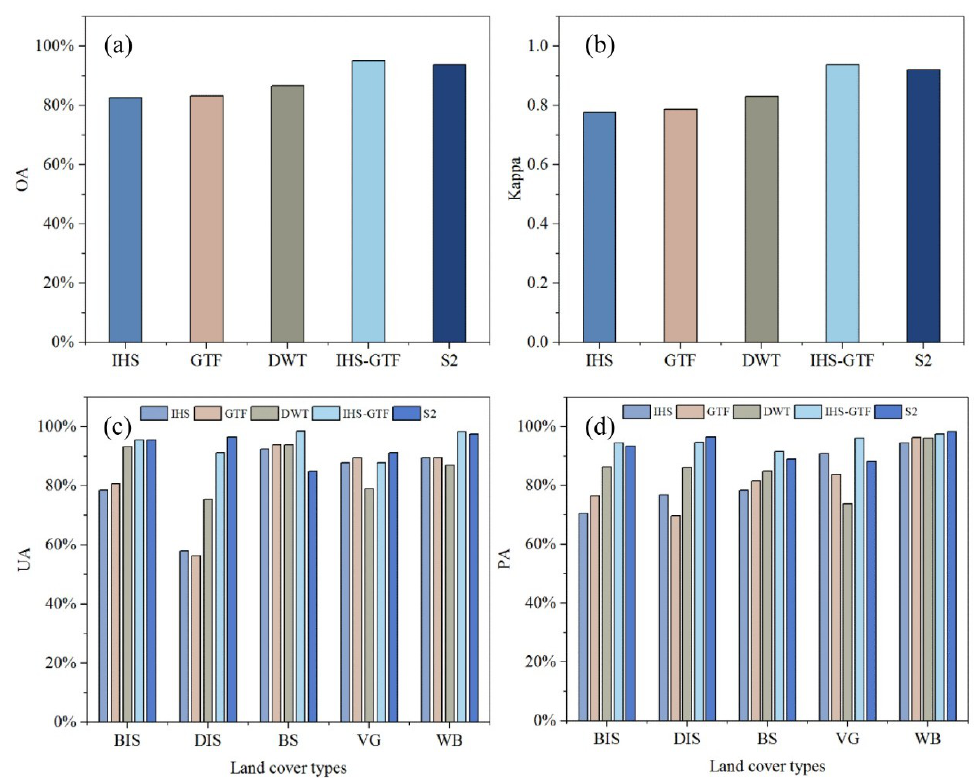
Figure 7. Comparison of classification results with different images in Site 1: ( a ) OA; ( b ) Kappa coefficients; ( c ) UA; and ( d ) PA.